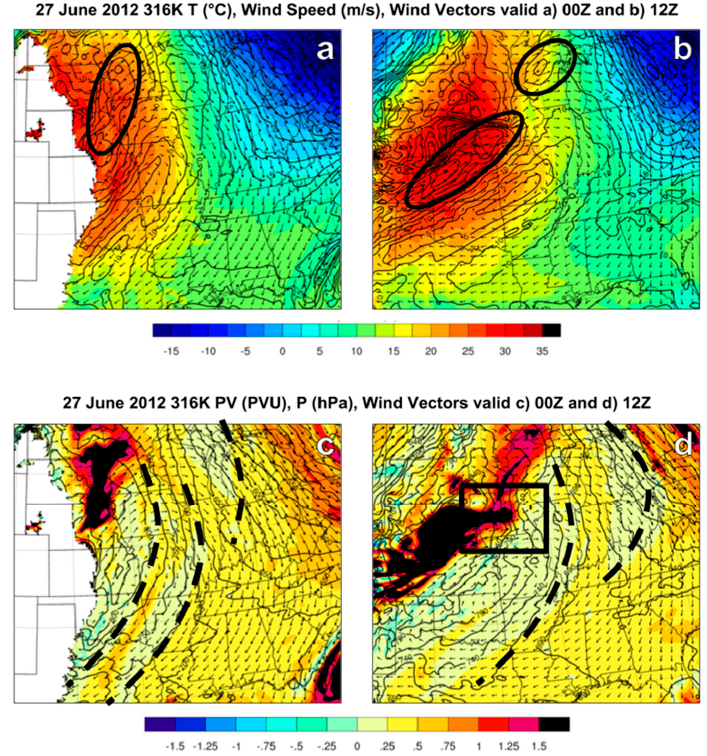
Figure 16. WRF-ARW 18 km simulated 316 K temperatures (°C, color fill), wind isotachs (black lines in m/s), and wind vectors for ( a ) 00Z and ( b ) 12Z 27 June, as well as simulated 316 K potential vorticity (PVU, color fill), pressure (black lines in hPa), and wind vectors valid at ( c ) 00Z and ( d ) 12Z 29 June. The white-filled areas in panels ( a , c ) represent locations where the isentropic surface is interrupted by higher terrain. Black ovals indicate the location(s) of mid-level jetlets (MLJ). The black box shows where along stream perturbations and deformation of the EML are occurring, and black dashed lines indicate surges of the EML eastward out of the main high.